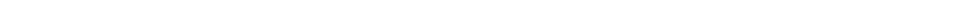
(see fi gure on previous page) Fig. 1 Characterization of crypt-like and villus-like human small intestinal organoids. A Bright fi eld images representing different phenotypes of hSIOs cultured in complete growth medium (GM) for 12 days (upper panel, scale bar = 200 µm) and differentiated hSIOs grown in GM for 7 days followed by 5 days in differentiation medium (DM) (lower panel, scale bar = 100 µm). B mRNA expression of crypt cell markers OLFM4 (stem cells) and LYZ (Paneth cells) and villus cell markers I-FABP (absorptive enterocytes) and MUC2 (Goblet cells). Data were normalized to B2MG and ACTB reference genes, and reported as relative expression as compared to GM (set at 1). Results were obtained from 4 different hSIO lines ( n = 10 – 11, Mean ± SD, *** P < 0.001, **** P < 0.0001, Mann Whitney U-test). OLFM4 Olfactomedin, LYZ Lysozyme, I-FABP Intestinal fatty acid-binding protein, MUC2 Mucin 2. C Representative stainings for intestinal protein markers in sections of GM- and DM-cultured hSIO. Proliferation marker Ki67, lysozyme- containing Paneth cells, Alcian Blue-stained Goblet cells, and Alkaline phosphatase staining of the brushborder. Scale bar = 50 µm. D Western blot analysis of lysozyme and IFABP. Band intensity was quanti fi ed and normalized using β -actin as loading control. Relative expression is shown as mean ± SD ( n = 5, obtained from 3 different hSIO lines; ** P < 0.01, Mann Whitney U-test). Full blots can be found in Fig. S1. E Heatmap showing relative change of differentially expressed proteins ( P < 0.05). Proteins with on/off expression are excluded from the heatmap and can be found in Table S1. n = 6 from 3 different hSIO lines. F List of known protein markers for intestinal cell-types, with respective abundance ratio (DM/GM) and adjusted p - value. AE absorptive enterocytes, GC Goblet cells, SC stem cells, PC Paneth cells. G Functional enrichment analysis showing GO biological processes signi fi cantly enriched (adjusted p -value < 0.05, corresponding to − log( p- value) > 1.3) in DM organoids and GM organoids. Protein lists for enrichment analysis: upregulated in DM p -value < 0.05; upregulated in GM p -value < 0.1. See also Table S1 for the lists of proteins used for enrichment analysis.